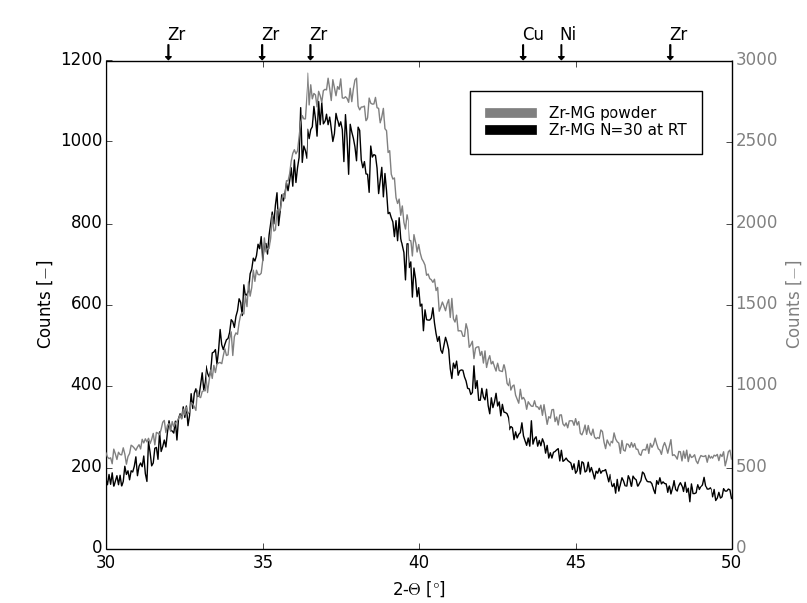
Figure 4. XRD measurement of the HPT deformed sample and the undeformed powder (gray